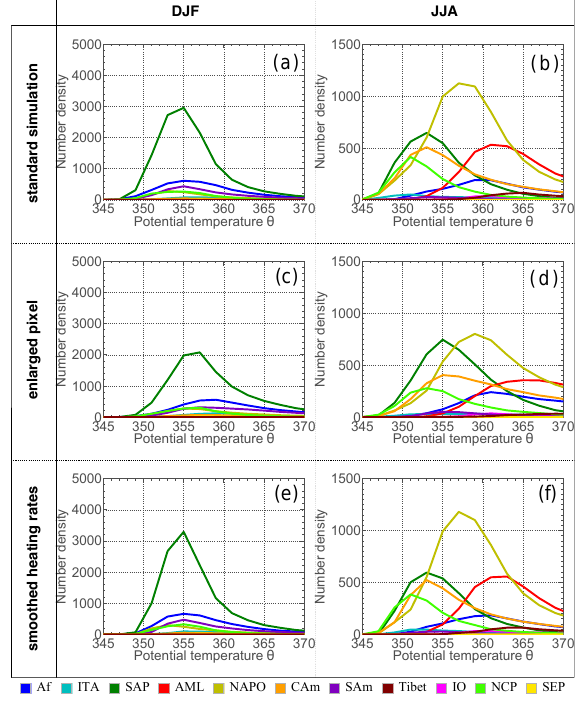
Figure 7. Comparison of the vertical source distribution, for ERA- Interim, for boreal winter (DJF) and boreal summer (JJA) between the standard backward calculation for 2005 (upper two panels), when the CLAUS pixel size is enlarged by a factor of 3 as described in the text (middle two panels) and when the 3-hourly sampling of daily cycle of heating rates is replaced by a time moving average as described in the text (lower two